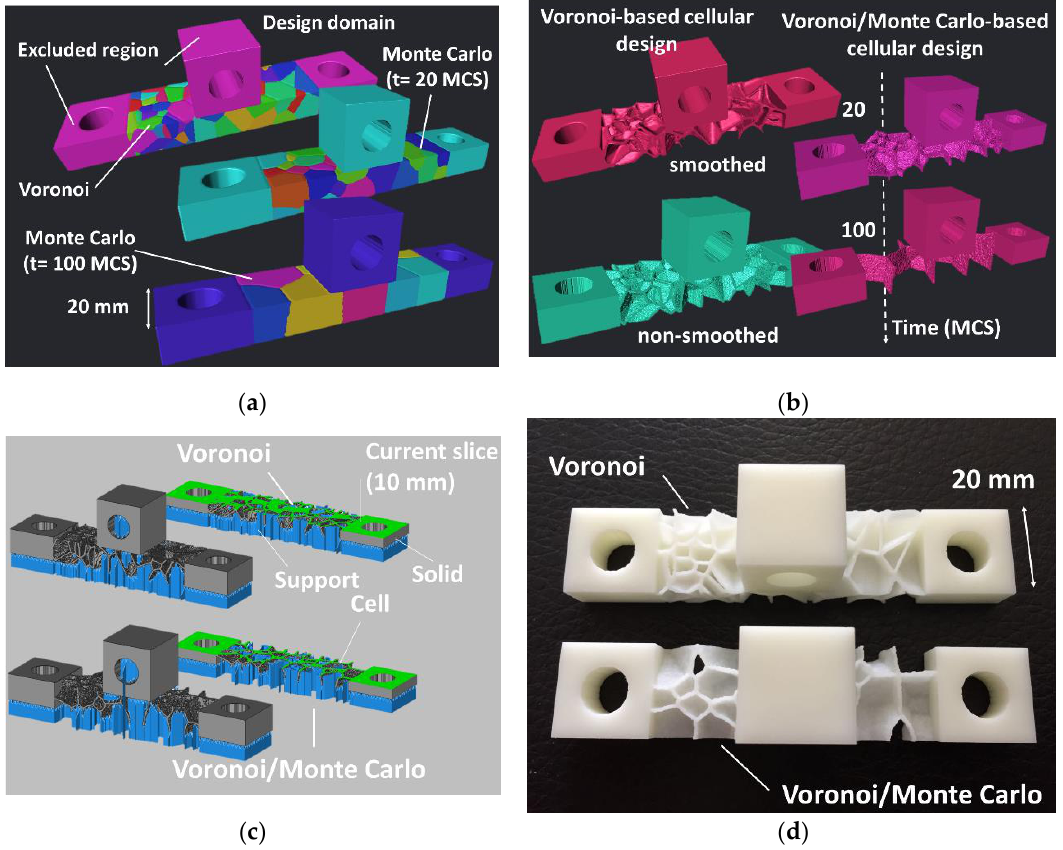
Figure 14. Extension of the Voronoi–Monte Carlo approach to the design of technical parts, ( a ) The generated Voronoi 3D structure based on 100 seed points and subsequent Monte Carlo structures at two di ff erent time steps (MCS), ( b ) the cellular designs achieved at di ff erent stages including the Voronoi-based and the Voronoi / Monte Carlo-based, ( c ) slicing and ( d ) 3D printed designs using